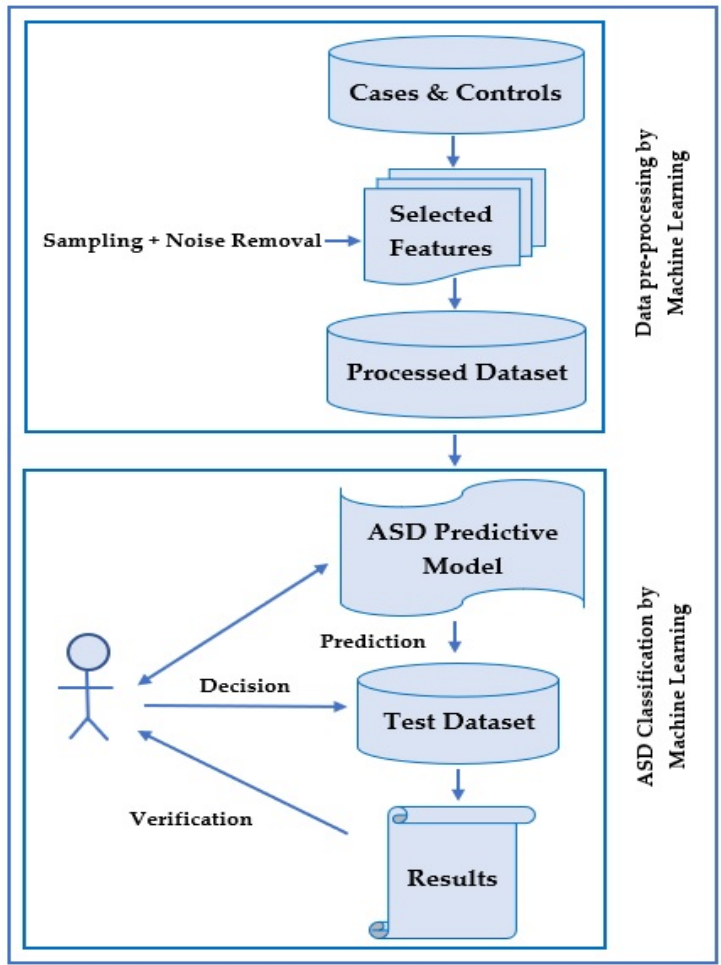
Figure 5. ASD classification with machine learning.